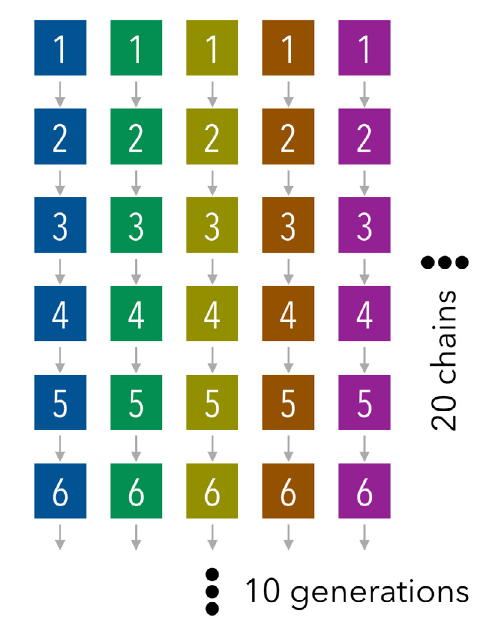
Figure 1 : The iterated learning design. Each participant is assigned to one of 20 chains. They learn the language produced by the previous participant in their chain, with the exception of the first participant in a chain, who learns a randomly construc- ted language. In this way, each participant belongs to a generation, and we observe the cultural evolution of the language down 10 generations of iterated